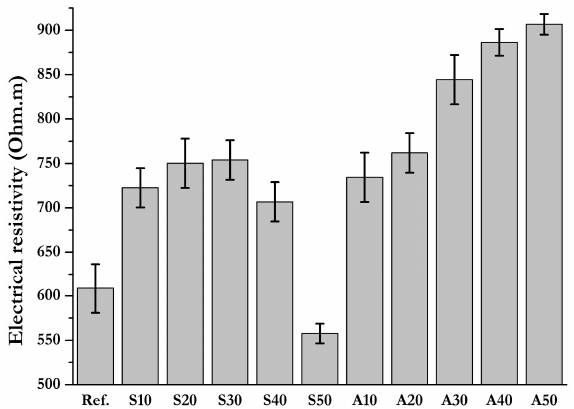
Figure 9. Electrical resistivity of concrete.